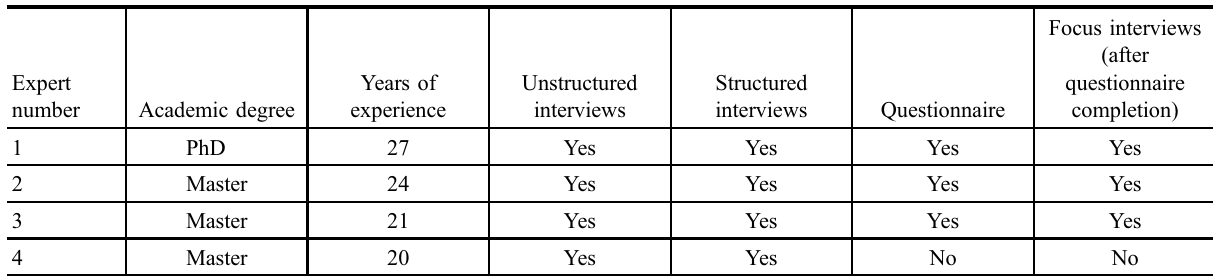
Table 3. Experts involved in expertise